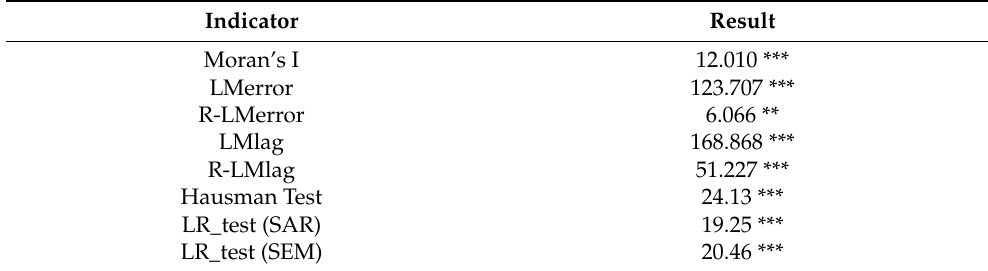
Table 4. Test results of spatial econometric